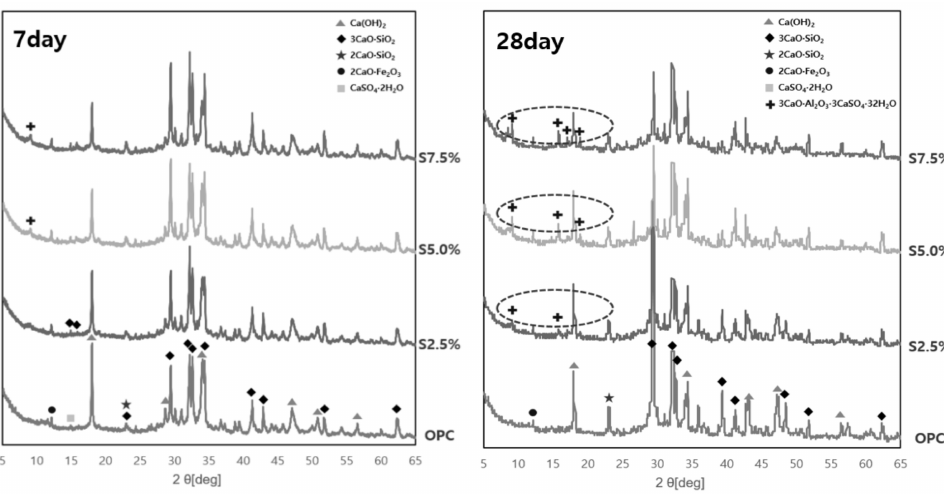
Figure 7. Hydrate XRD changes after 7 and 28 days. The degree of hydrate formation by age according to the rate of binding resistance is shown. The left side represents results for the specimen 7 days after specimen preparation, and the right side results for the specimen 28 days after specimen